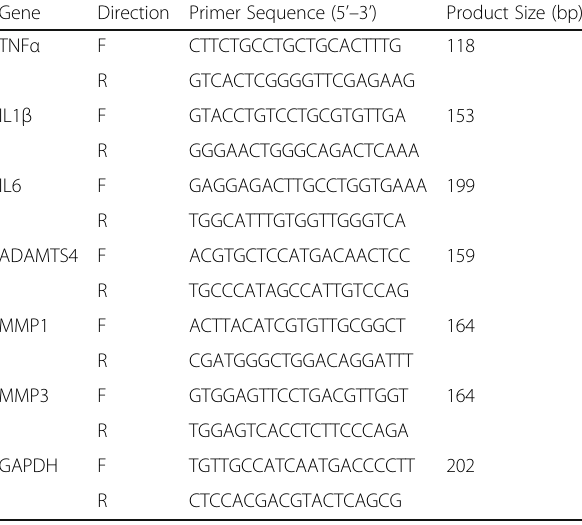
Table 1 Sequences of the primers used in this